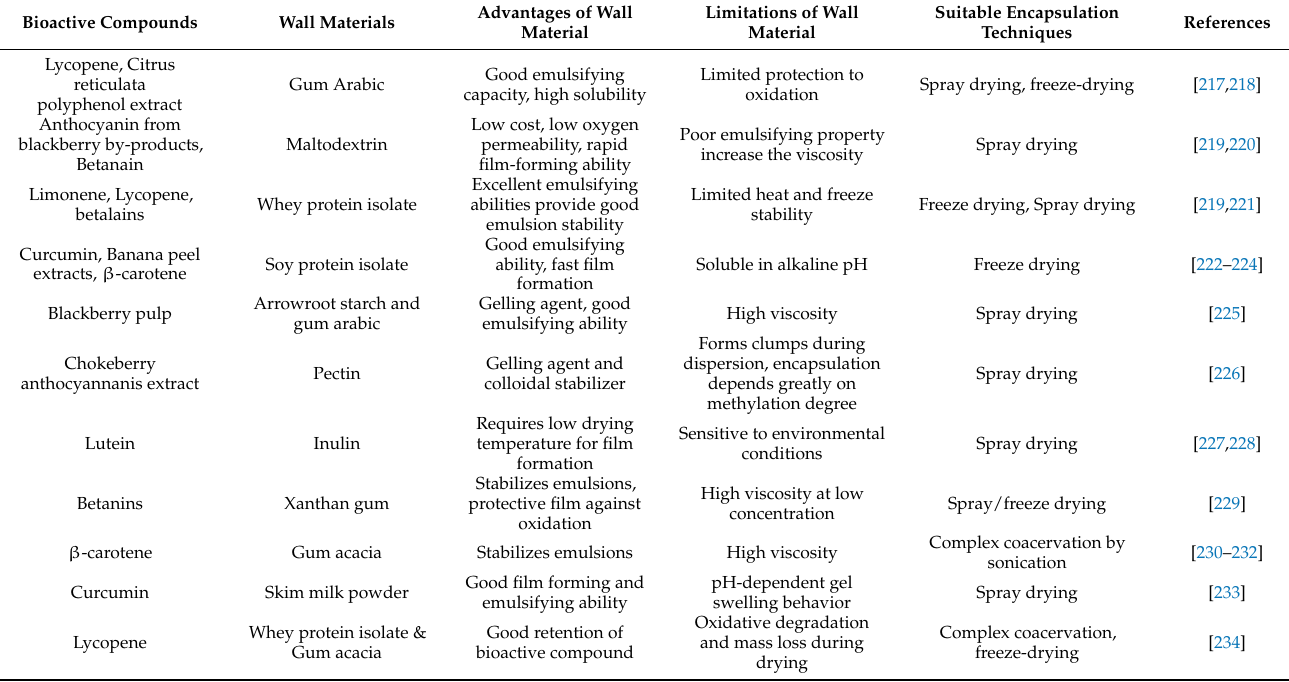
Table 3. Wall materials used for different bioactive compounds and their suitable encapsulation techniques.